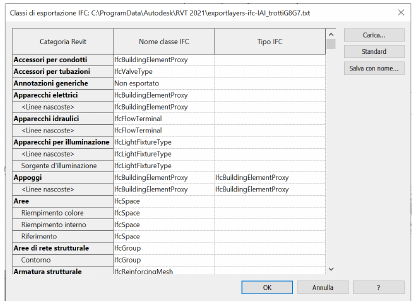
Figure 4 . IFC mapping table from Revit